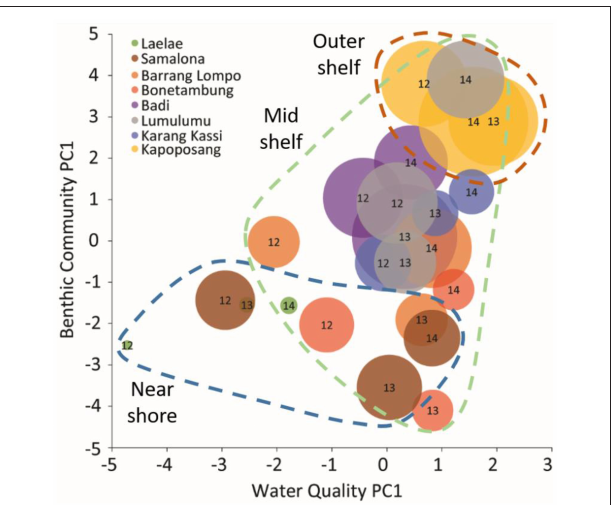
FIGURE 6 | Relationship of PC1s from independent benthic community ( Figure 5 ), water quality (Supplementary Figure 4), and fish indices (Supplementary Figure 5) PCAs. A higher score on the benthic PC1 indicates communities with relatively high cover (%) of reef builders while low values indicate high cover of algae ( Figure 5 ). A high value on the water quality PC1 indicates better water quality (i.e., low dissolved organic carbon and chlorophyll a and high oxygen). The size of the bubbles represents a relatively higher score on the fish PC1 indicating higher values in most fish community indices or, a healthier fish community. The numbers within the bubbles represent the year of sampling (2012: 12, 2013: 13, 2014: 14). Dashed lines indicate groups of sites relative to distance from shore (blue = nearshore, green = mid-shelf, and red = outer-shelf) providing visual interpretation. These groups are loosely based on Renema and Troelstra (2001), however Samalona was grouped with Laelae because values were similar, while Kapoposang was defined as the sole outer shelf site because its fish communities composition is